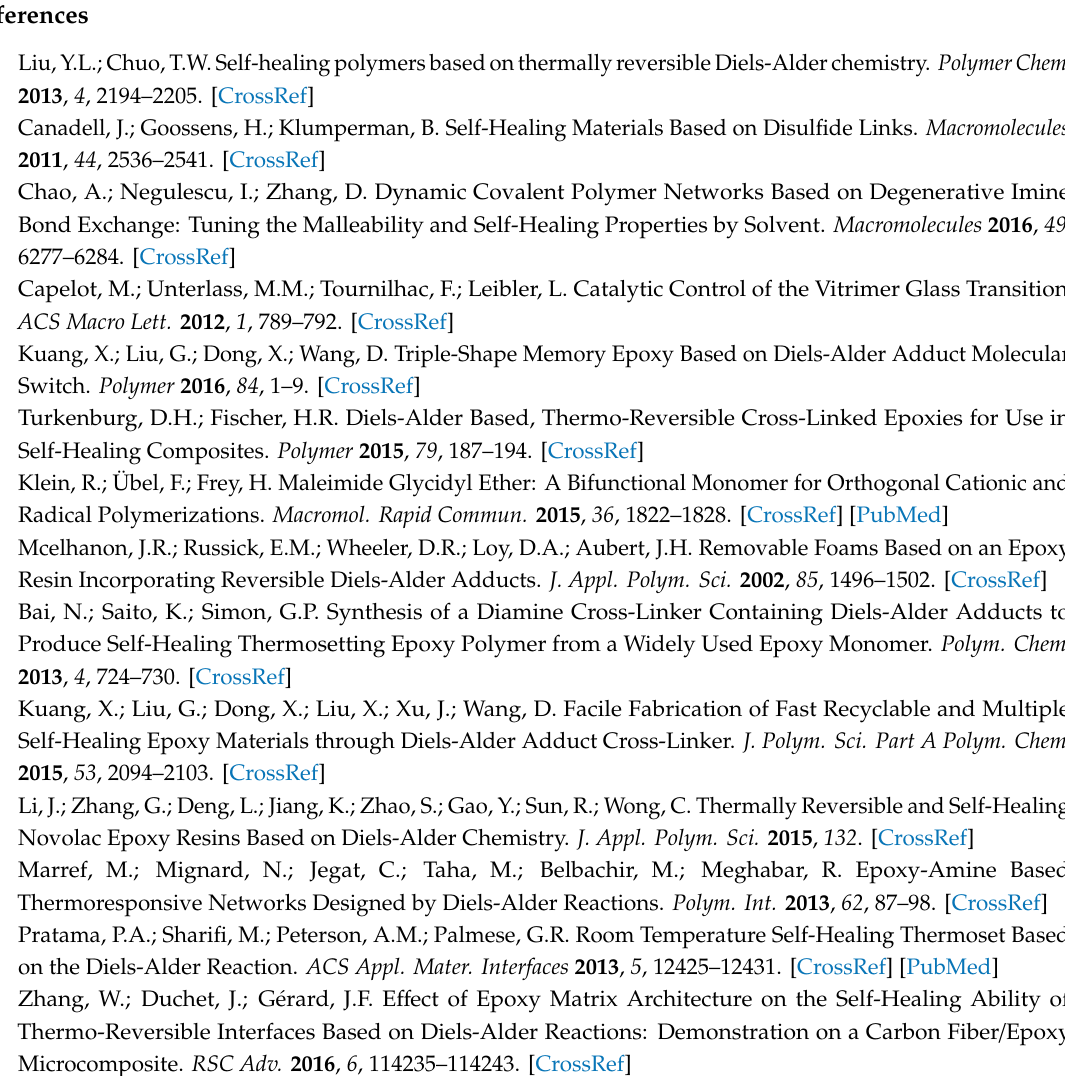
Table S1: Sample code and compositions of the GNP / EP nanocomposites; Table S2: Components of the surface tensions (20 ◦ C); Table S3: Relaxation times of D system nanocomposites; Figure S1: XPS spectra of GNPs and modified GNPs; Figure S2: FT-IR spectra of GEN-0.1-D and DGEBA; Figure S3: DSC thermograms of the CA and D systems of di ff erent GNP contents: (a) First scan; (b) Second scan after quenching at 0 ◦ C; (c) Second scan after the isothermal condition at 70 ◦ C for 1 h; Figure S4: DSC thermograms of the D system composites: (a) third scan; (b) repeated endothermic peak of